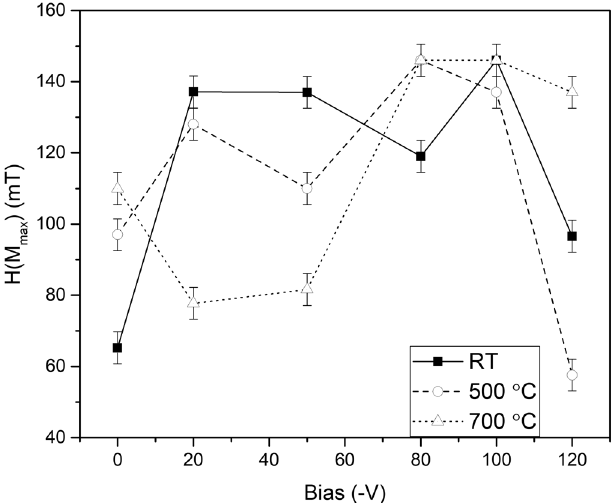
FIG. 5. The maximum recorded magnetization H ð M each deposited film.